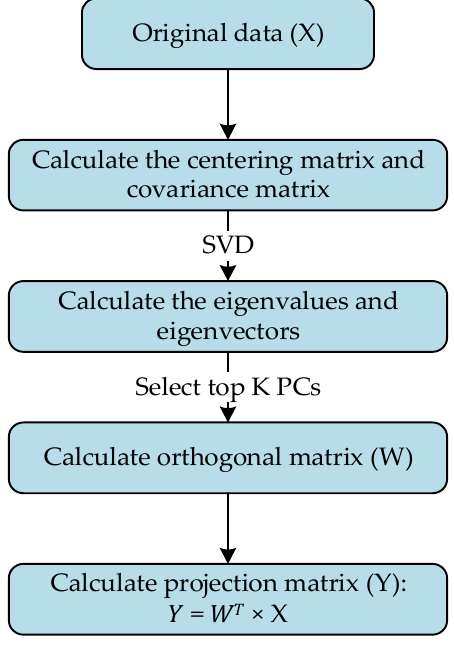
Figure 1. The flowchart of